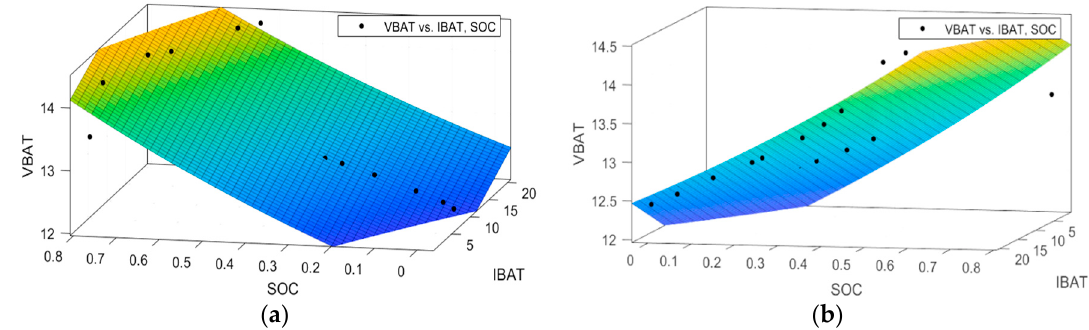
Figure 13. ( a ) Battery charge experimental data fitting results via MATLAB Curve Fitting Toolbox, frontal view and ( b ) lateral view and error analysis.